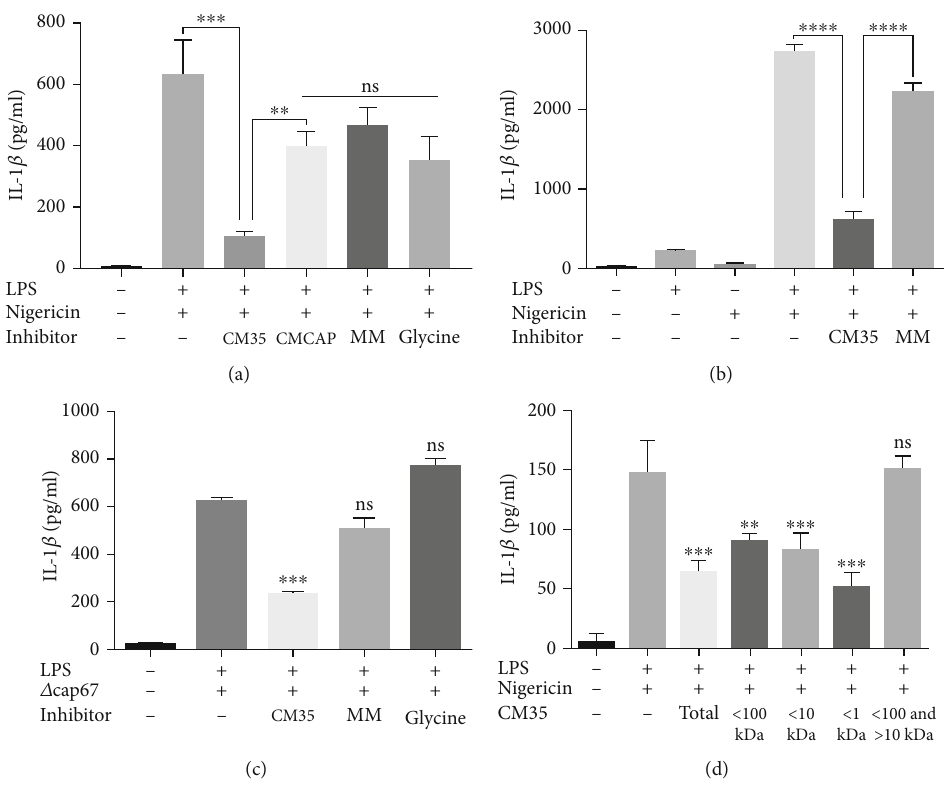
Figure 2: CM35, but not CMCAP or minimal media reduces IL-1 β secretion. (a) BMMs were stimulated with LPS (500ng/ml) and/or nigericin (20 μ M), added or not by mediums (CM35; CMCAP or MM 10% v / v ) or glycine (13 mM) overnight (18 h). (b) BMDCs were stimulated with LPS (500ng/ml) and/or nigericin (20 μ M), added by media (CM35 or MM 10% v / v ) overnight (18 h). (c) BMDMs were stimulated with LPS (500ng/ml), infected with Δ cap67 strain (MOI 5 :1), added or not by mediums (CM35 or MM 10% v / v ) or glycine (13 mM) overnight (18 h). (d) BMDMs stimulated with LPS (500ng/ml) and/or nigericin (20 μ M), added by CM35 > 100kDa, < 100 and > 10 kDa, < 10kDa and < 1 kDa (10% v / v ) overnight (18 h). Supernatants were collected after stimulus and cytokines were quanti fi ed by ELISA technique. CM35=conditioned media from B3501; CMCAP =conditioned media from Δ cap67 ; MM =minimal media. Statistical analysis was performed utilizing one-way ANOVA, where ns: not signi fi cant; ∗∗ P ≤ 0 : 002 ; ∗∗∗ P ≤ 0 : 001 . Comparisons were made with the positive control group (LPS+nigericin) when not indicated (c,